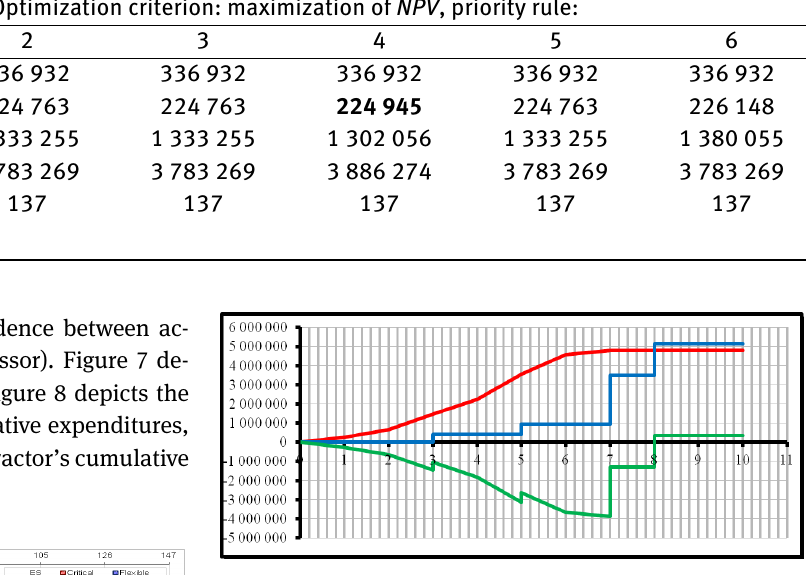
Figure 8: Contractor’s cumulative expenditures, client’s cumulative payments and contractor’s cumulative cash flow for the maximiza- tion of project NPV with the priority for works with higher direct